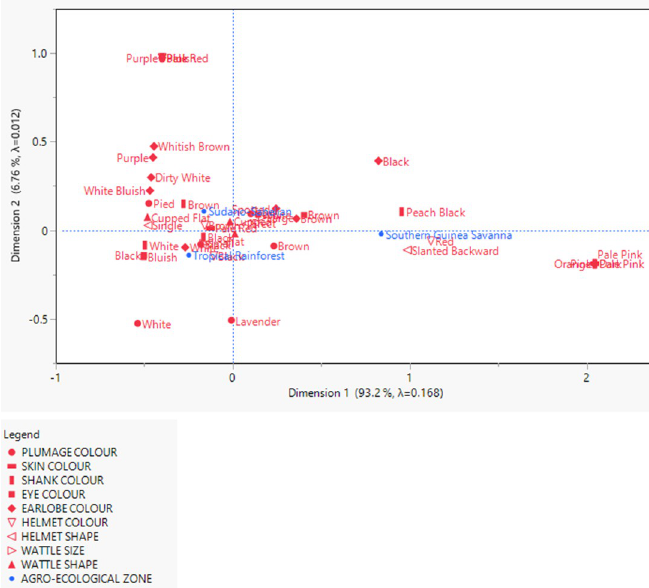
Fig 2. A biplot showing the relationship between the qualitative physical traits and agro-ecological zones. https://doi.org/10.1371/journal.pone.0261048.g002 Table 3. Medians (means in parentheses) of biometric traits and morphological indices of indigenous helmeted Guinea fowls based on agro-ecology.